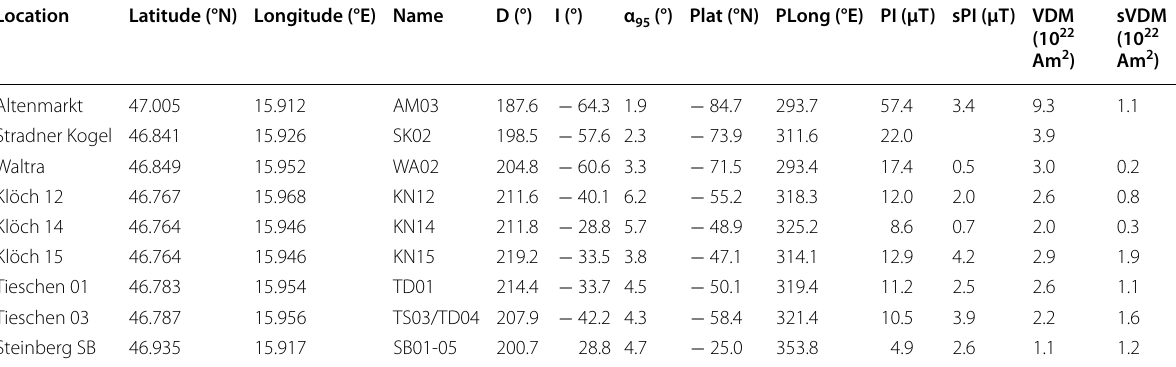
D : declination of the ChRM; I : inclination of the ChRM; α 95 : 95% confidence circle radius of the Fisher (1953) statistics; Plat: latitude of the VGP position; Plon: longitude of the VGP position; PI: mean paleointensity; sPI: standard deviation of paleointensity; VDM: virtual dipole moment from PI; sVDM: standard deviation of VDM